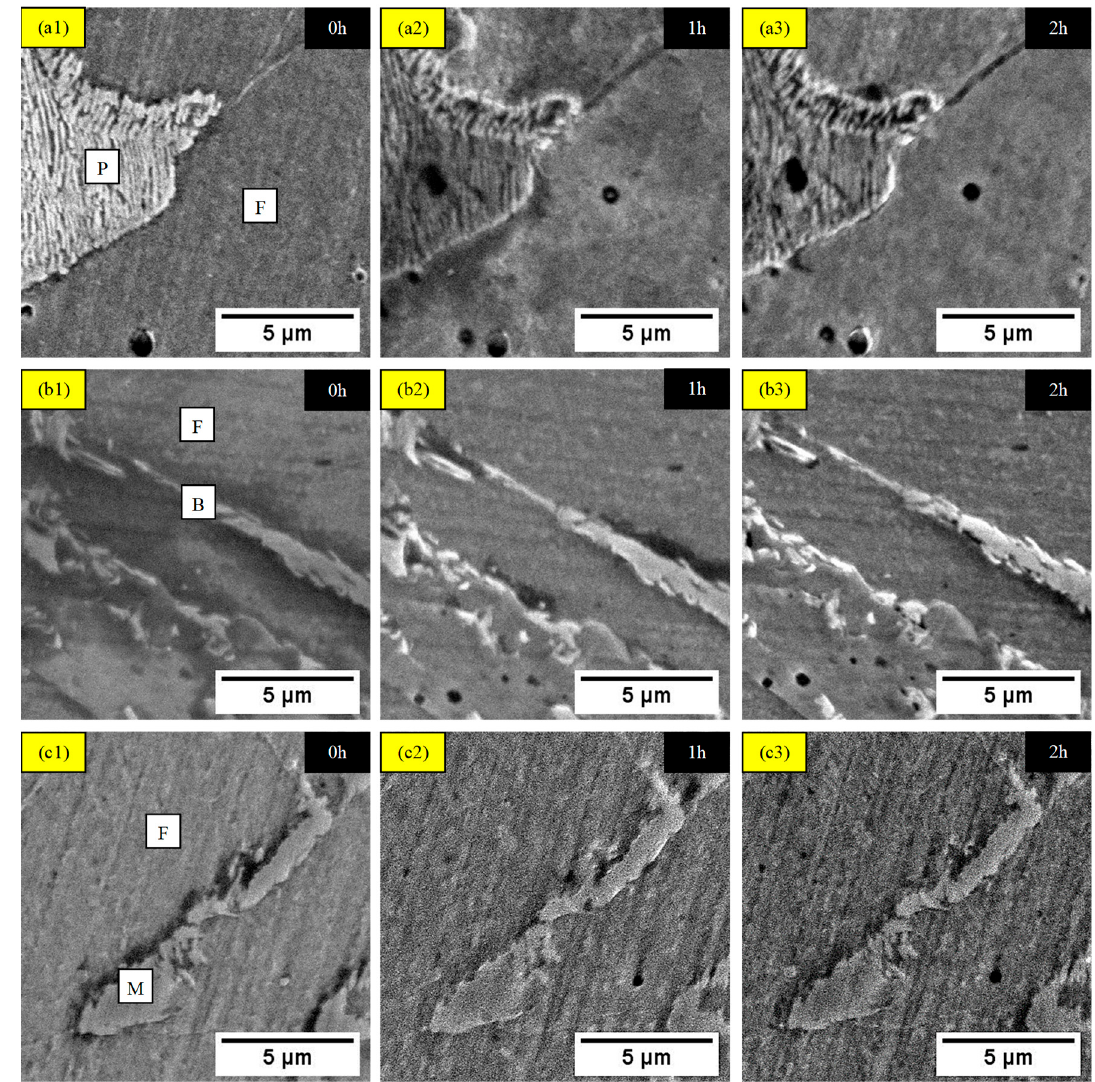
Figure 5. SEM imaging of surface evolution by different time of corrosion for ( a1 ), ( a2 ) and ( a3 ) DS ferrite/pearlite, ( b1 ), ( b2 ) and ( b3 ) TS ferrite/bainite, ( c1 ), ( c2 ) and ( c3 ) TS ferrite/martensite in 3.5 wt.% NaCl solution.